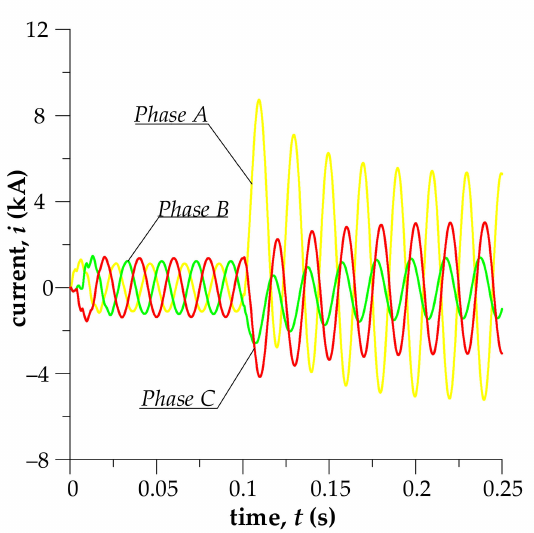
Figure 10. Transient currents in the middle line section for the second experiment.